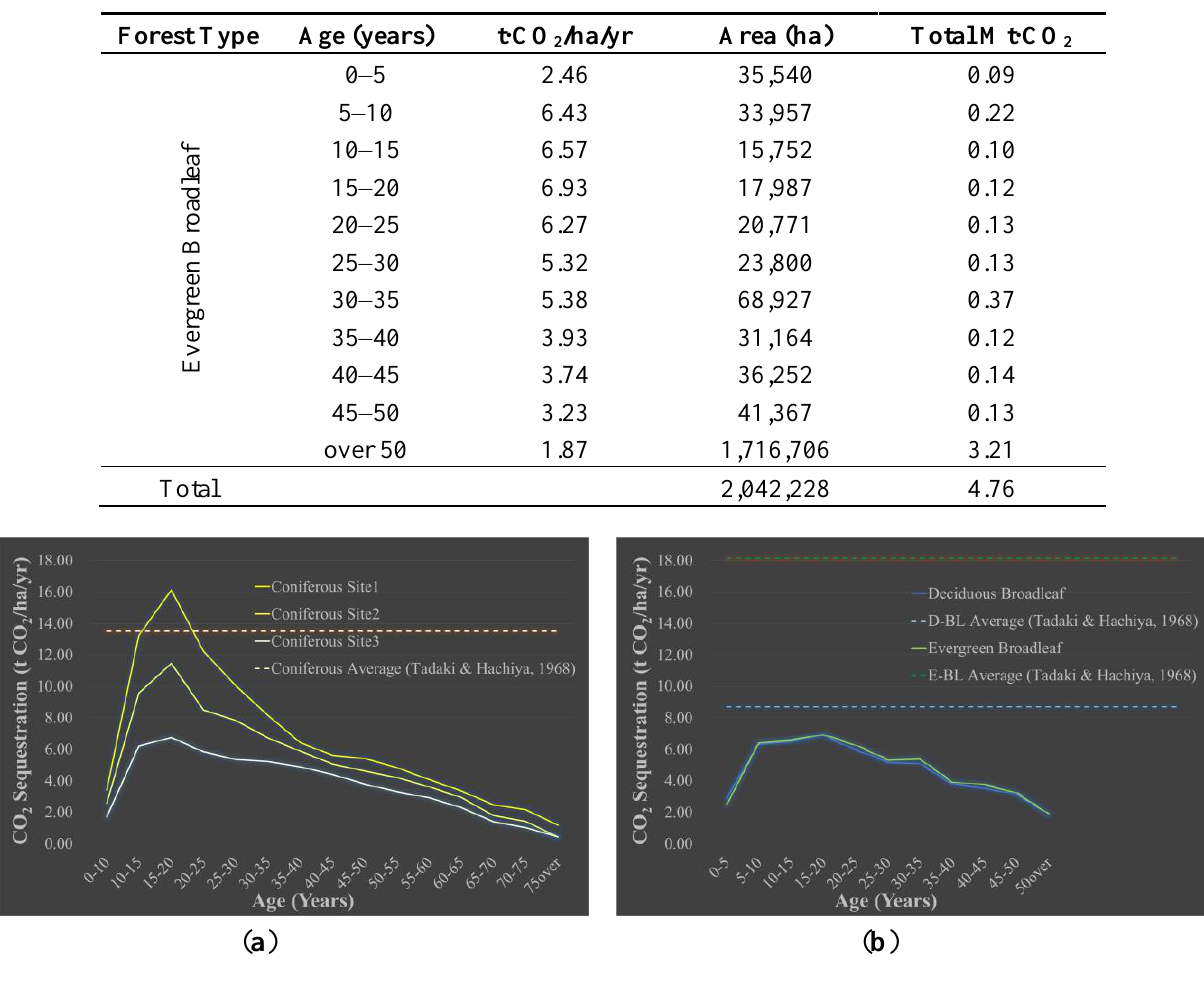
Table 5. CO 2 sequestration of evergreen broadleaf forests by tree age using the PALSAR data and the stem volume method.